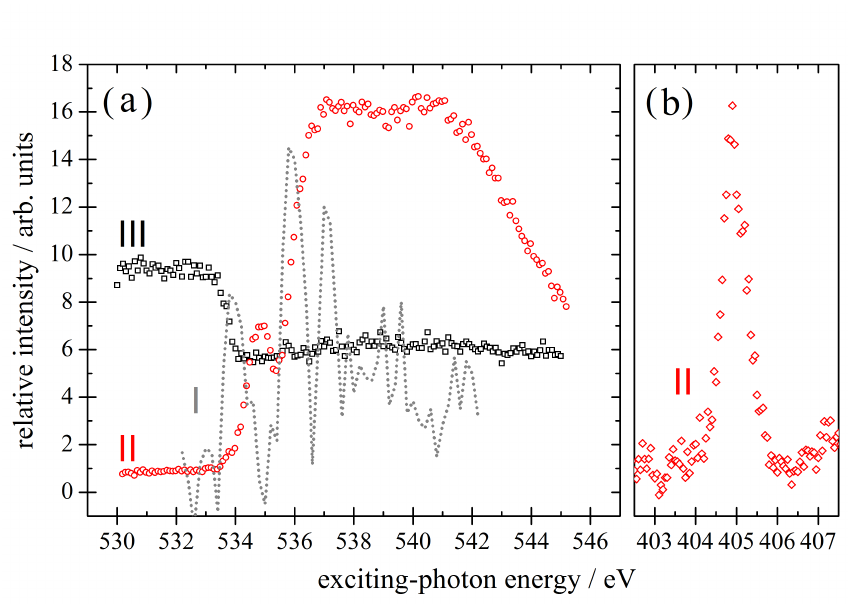
Figure 10. ( a ) emission intensity of three distinct processes initiated by the interaction of synchrotron radiation with a liquid microjet as a function of the exciting photon energy in the vicinity of the water K -shell threshold. The emissions are labelled according to the processes described in Figure 9; ( b ) intensity of emission following process II of a 1 molar NaNO 3 solution in the vicinity of the nitrogen K-edge. For details, see text and Ref. [45]. Reprinted with permission from The Journal of Physical Chemistry 121, 2326. Copyright 2017 American Chemical